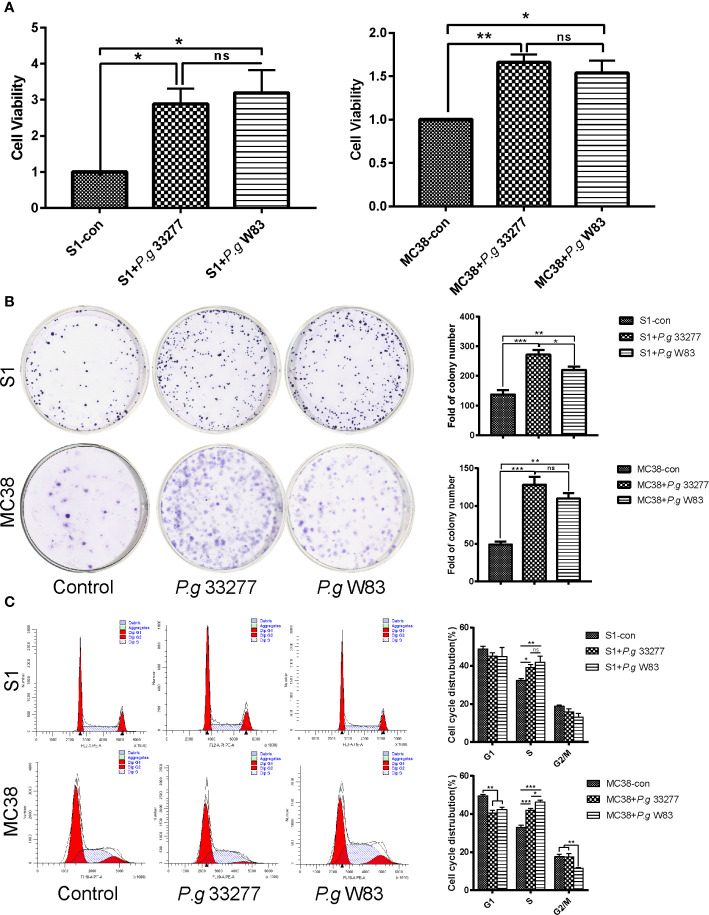
Cell proliferation and cell cycle analyses of CRC cells pretreated with P. gingivalis. (A) CCK8 assay examination of the proliferation of S1 and MC38 cells pretreated with P. gingivalis 33277 and W83 for 24 h. (B) Colony formation assay examination of the proliferation of S1 and MC38 cells pretreated with P. gingivalis 33277 and W83. (C) Cell cycle analysis of S1 and MC38 cells pretreated with P. gingivalis 33277 and W83 detected by flow cytometry. The results showed that the fraction of S phase cells was significantly increased. *P < 0.05, **P < 0.01, ***P < 0.001. ns, nonsignificant.